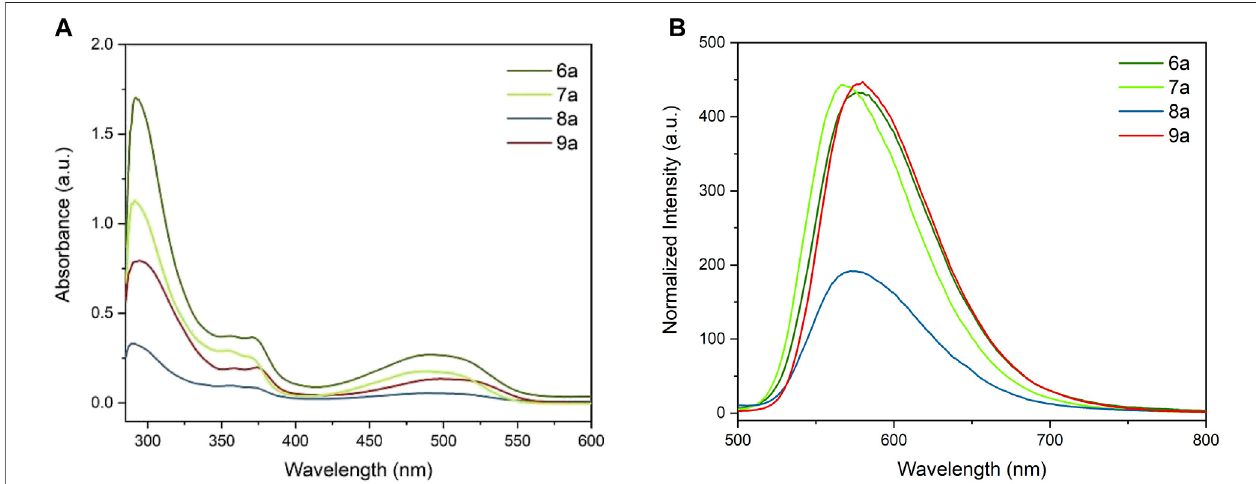
FIGURE 3 | (A) UV – Vis absorbance of 6a – 9a (0.05 mg/ml) in THF. (B) Normalized fl uorescent spectra of 6a – 9a (0.05 mg/ml) in THF. Excitation wavelength for 6a – 9a : 323 nm.